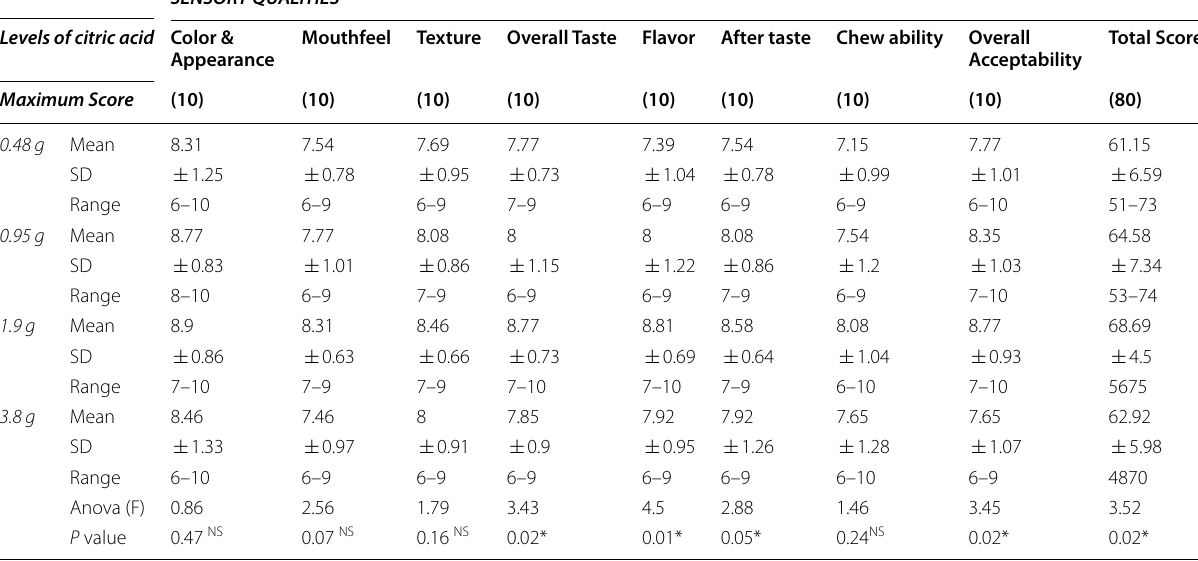
Table 4 Standardization with varying levels of citric acid